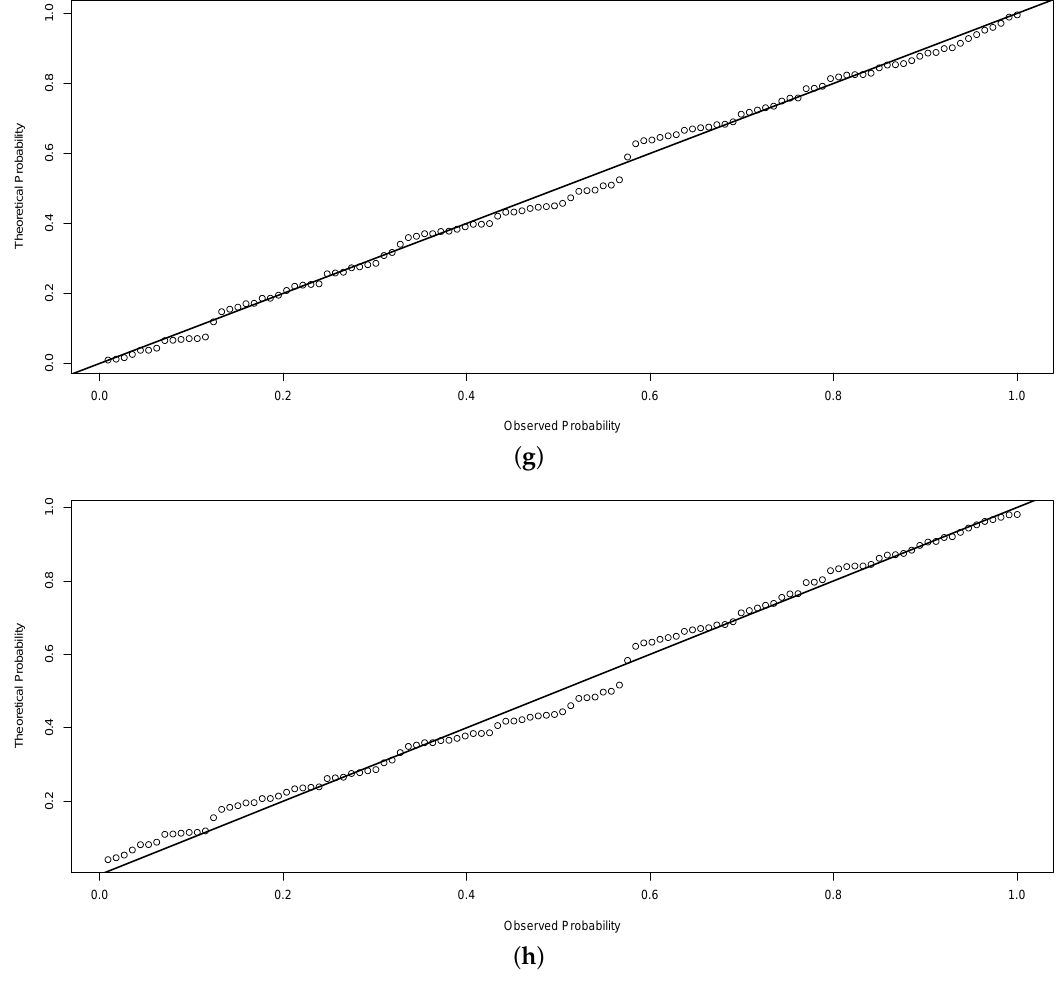
Figure 6. Education data - PP-Plot. ( a ) Skew Normal-GL; ( b ) Skew GL-Normal; ( c ) Skew t -GL; ( d ) Skew GL- t ; ( e ) Skew Normal-Logistic; ( f ) Skew Logistic-Normal; ( g ) Skew t -Logistic; ( h ) Skew Logistic- t . Table 1. Performance and accuracy of the